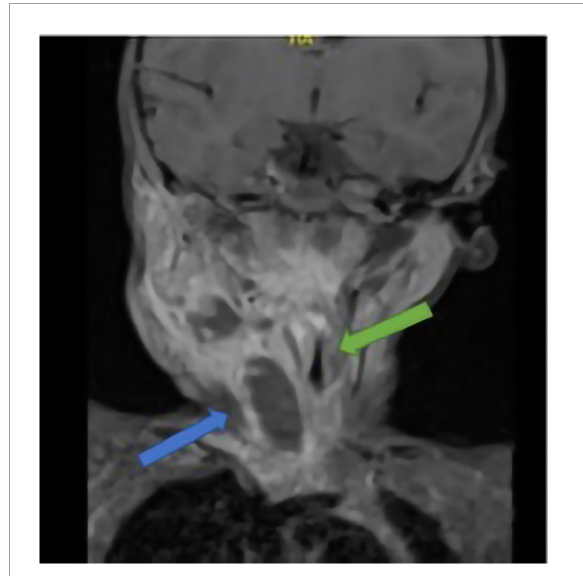
FIGURE2 Cervical MRI of case 2; blue arrow: abscess; green arrow: trachea